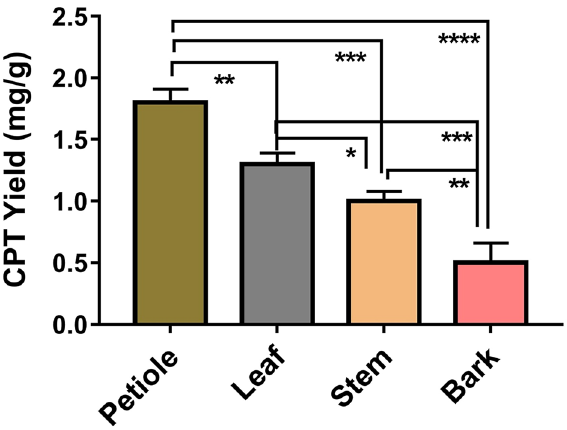
Figure 1. Camptothecin yield obtained from the different explants (plant parts) of N. nimmoniana plant used for the isolation of CPT yielding endophytes.